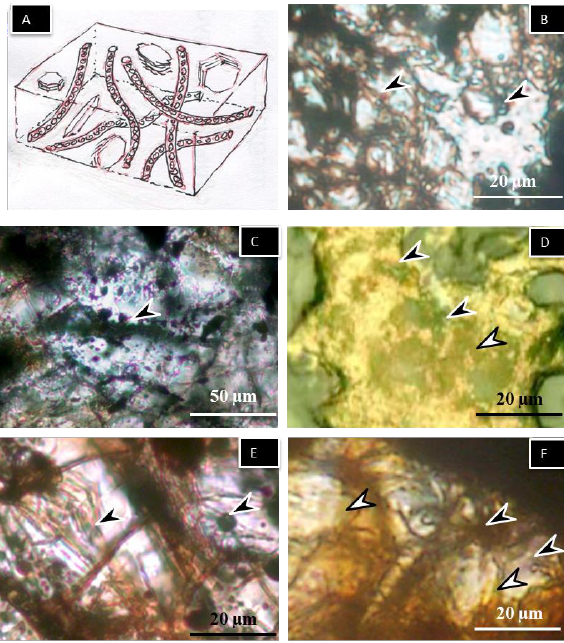
Figure 1. Terrestrial examples for microbial mediation. A: Filamen- tous Fe-oxide-hydroxide-bearing biosignatures formed most prob- ably by iron-oxidizing bacteria (FeOB) (black arrow) in quartz from Mátra Mountains and celadonite- and organic matter-bearing min- eralized EPS (greenish halo) around the filamentous biosignature (white arrow) (15 My) (Müller, 2009). B: Filamentous goethite- bearing biosignatures formed most probably by iron-oxidizing bacteria (FeOB) (black arrow) in quartz from Úrkút, Csárdahegy (190 My) (Polgári et al. , 2012a,b). C: coccoidal and filamentous FeOB (black arrows) with cyanobacteria (gray arrows) (635 Ma, Naraachamspos, Namibia). D: Bioweathering of chlorite by fila- mentous FeOB (black arrows) (635 Ma, Naraachamspos, Namibia) (Gyollai et al. , 2017a). E: Filamentous FeOB (black arrow) from Sesfontain-Opuwo (750 Ma, Namíbia) F: coccoidal FeOB (black ar- row) and cyanobacteria (grey arrow) from Sesfontain-Opuwo (750 Ma, Namíbia) (Gyollai et al. , 2015).